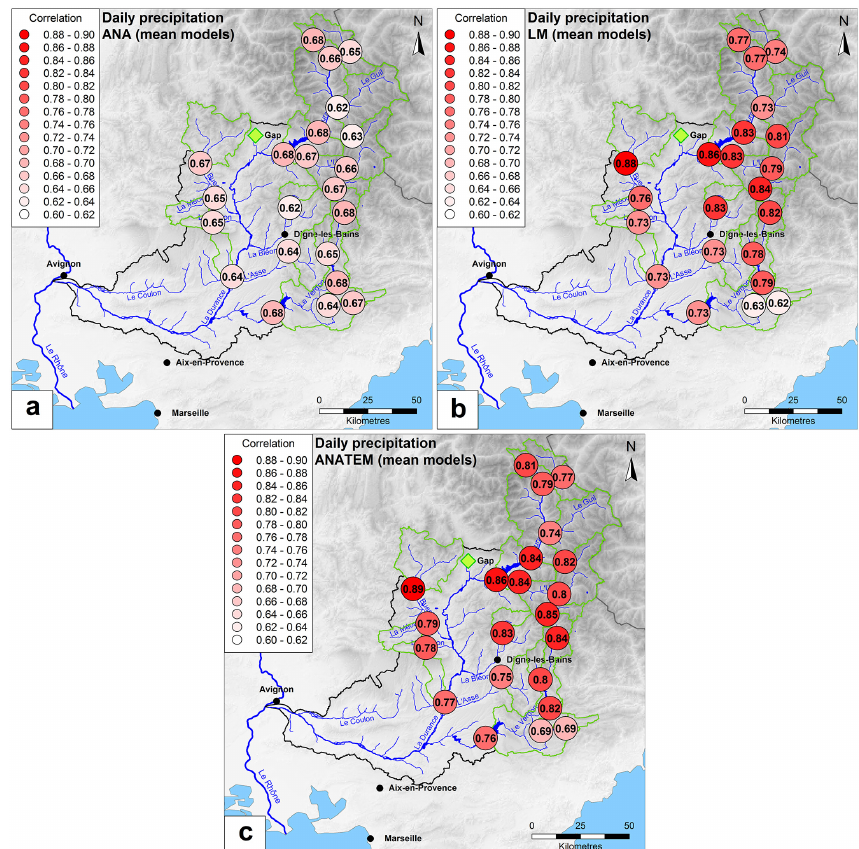
Figure 13. Regional correlation patterns of precipitation mean reconstructions by the (a) analogue model (ANA), (b) local model (LM) and (c) ANATEM model (daily time